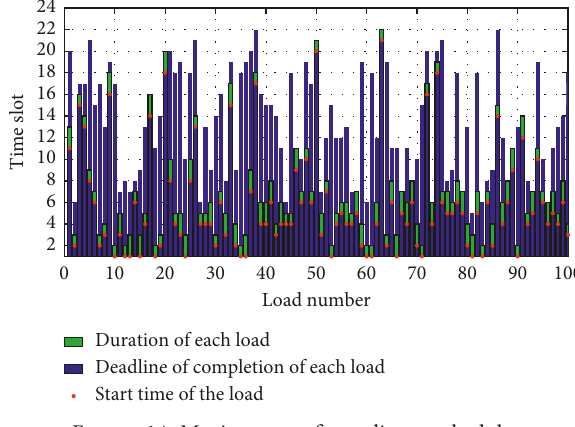
Figure 14: Maximum profit appliance schedule.